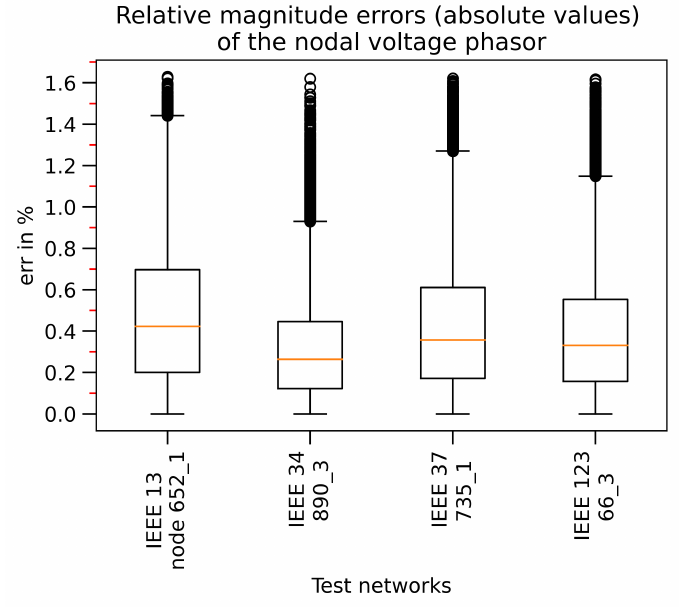
Figure 7. Distribution of relative errors of nodal voltage phasor magnitudes for nodes with the highest errors.